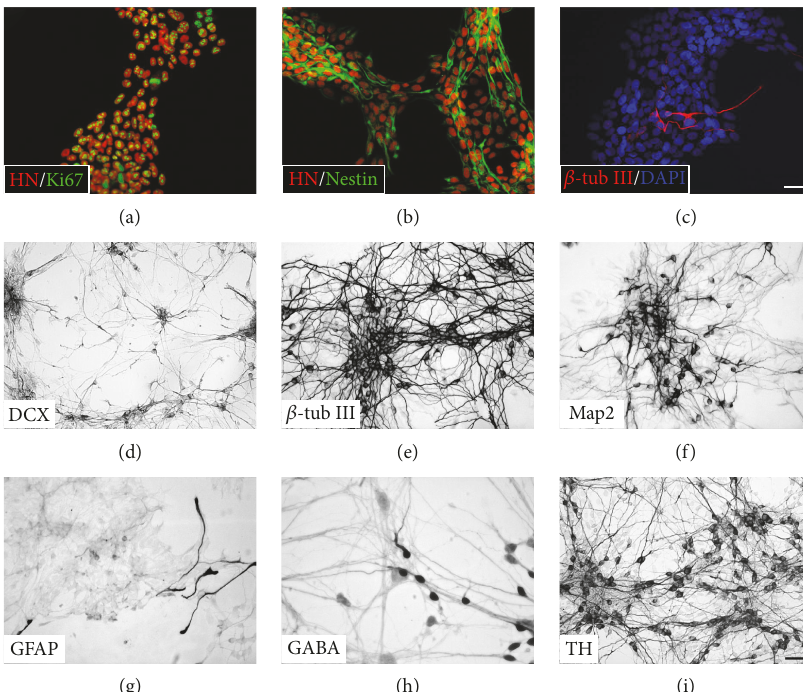
Figure 1: Immunocytochemical characterization of proliferating (a, b, c) and di ff erentiating human midbrain-derived stem cells (d, e, f, g, h, i). Immuno fl uorescence staining of cultures propagated for 4 days by exposure to epidermal growth factor and basic fi broblast growth factor was performed. Almost all cells expressed Ki67, a marker of dividing cells (a). Moreover, a large proportion of the cells expressed the intermediate fi lament protein nestin, a marker of neural progenitor cells (b). Only very few cells had spontaneously di ff erentiated into β -tubulin III- ( β -tub III-) positive neurons (c). Cells were di ff erentiated for 10 days by exposure to fi broblast growth factor 8 for three days followed by exposure to forskolin, sonic hedgehog, and glial cell line-derived neurotrophic factor for seven days and immunostained for neuronal and astroglial markers. At this time point, some cells expressed the early marker of migrating neuronal cell doublecortin (DCX) (d), whereas extensive staining for another early neuronal marker, β -tub III (e), and a mature neuronal marker, microtubule-associated protein 2ab (Map2) (f), was seen. A large proportion of cells expressed tyrosine hydroxylase (TH), a marker of catecholaminergic neurons (i), whereas only few cells were found to express γ -aminobutyric acid (GABA), a marker for GABAergic neurons (h). Very few cells were found to express glial fi brillary acidic protein (GFAP), a marker of astroglial cells (g). Scale bars =50 μ